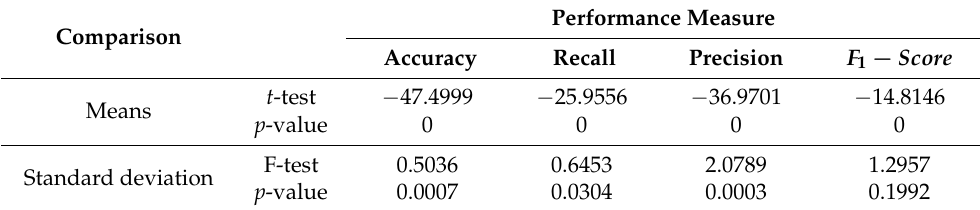
Figure 13. Performing measures for CNN and RBNN based classifier: ( a ) perimeter, ( b ) length of mayor axis, ( c ) length of minor axis, and ( d ) roundness. Table 1. Statistics for the comparison of the